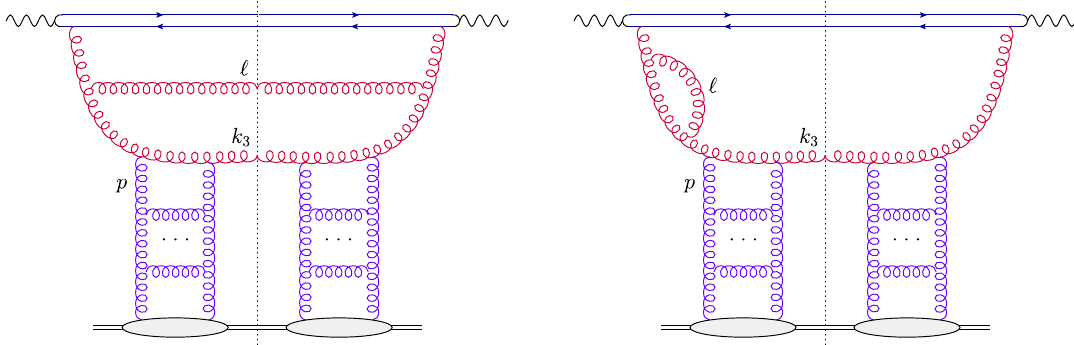
Figure 16 . Diagrams with an additional real (left) or virtual (right) gluon which contribute to the diffractive process at